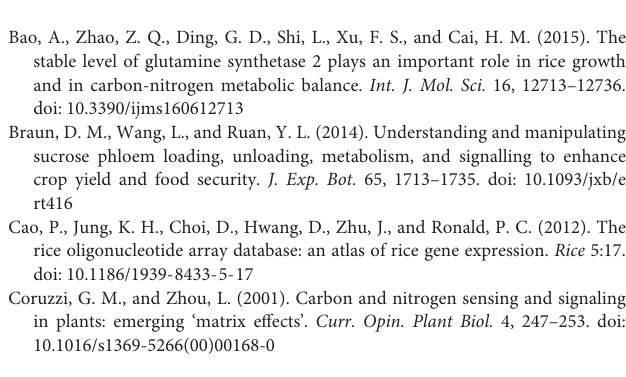
Supplementary Figure 5 | Sugar contents in OsDOF11 mutant seeds. (A) Total starch content based on dry weight; (B) apparent amylose content based on dry weight. Each data point represents the mean ( ± SE) from at least four different samples. Supplementary Table 1 | Microarray analysis of amino acid metabolism-related genes in flag leaves. Supplementary Table 2 | Free amino acid content in flag leaf. Supplementary Table 3 | Free amino acid content in